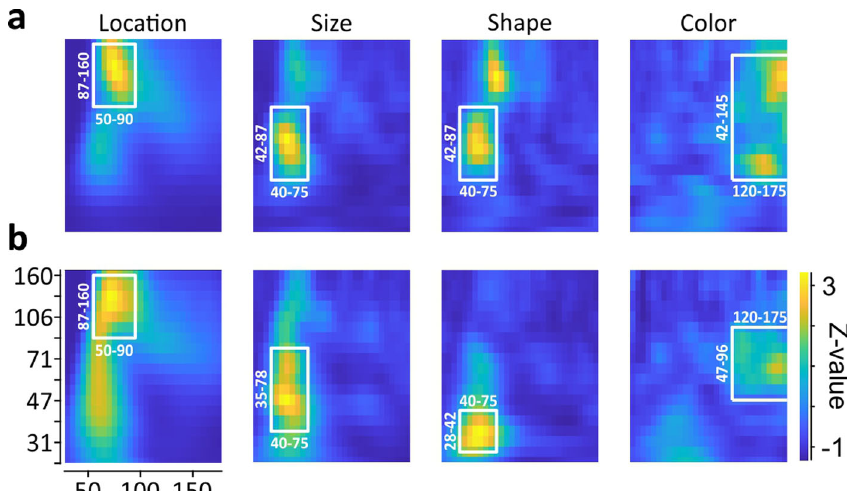
Fig. 2 Time-frequency ranges used for EFP analysis. a – b Color maps show variance in area-under-the ROC curve overall electrodes ( N = 313), for stimuli sorted according to location, size, shape, and color, separately for M1 ( a ) and M2 ( b ). Y -axis indicates wavelet frequency ranges [Hz], x -axis indicates time [ms], aligned to stimulus onset. White boxes delineate the selected time-frequency range per feature and monkey. Color scaling is identical for all